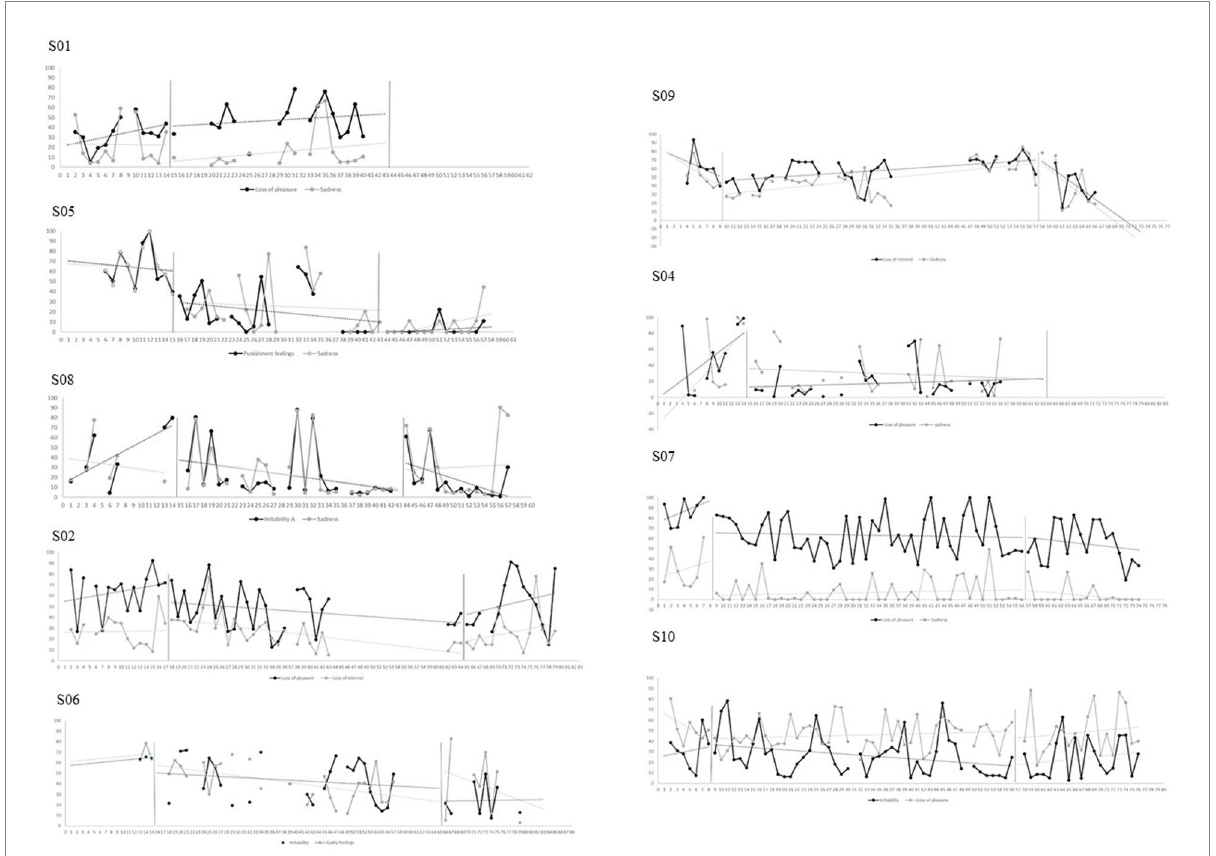
FIGURE 3 Raw data and trend for participants’ depressive symptoms